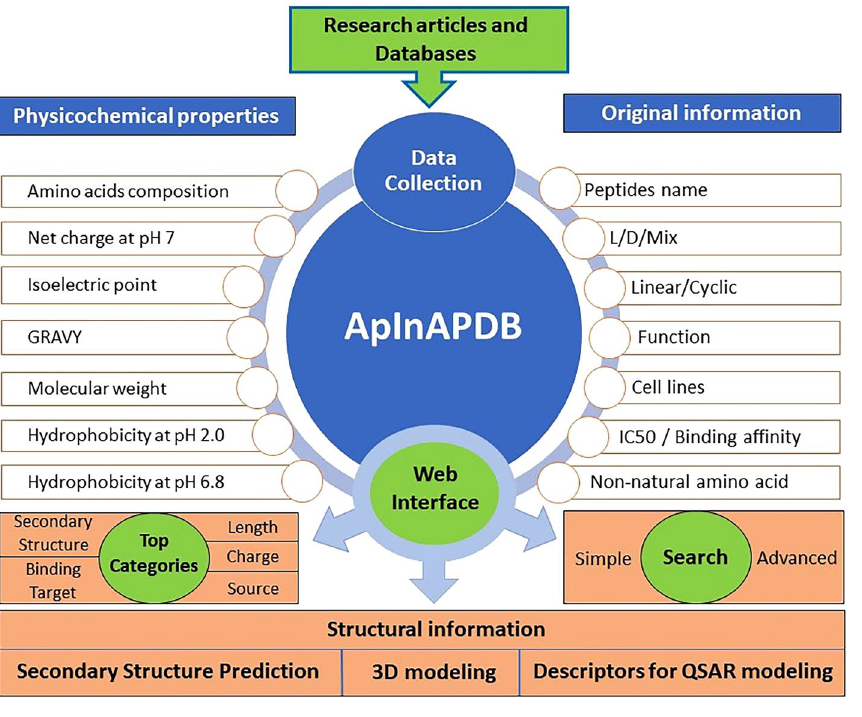
Figure 1. Overall structure and features of